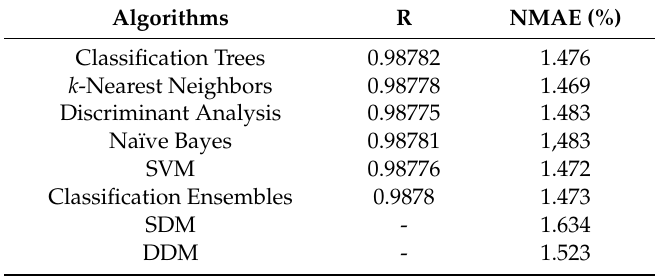
Table 4. R and normalized mean absolute error (NMAE) related to six classification algorithms.